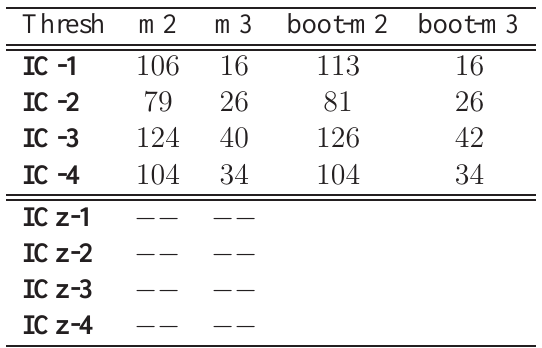
Table 4: Outliers from the estimated components (m2 and m3), and from bootstrapped compo- nents (boot-m2 and boot-m3). Bootstrap values are reported.